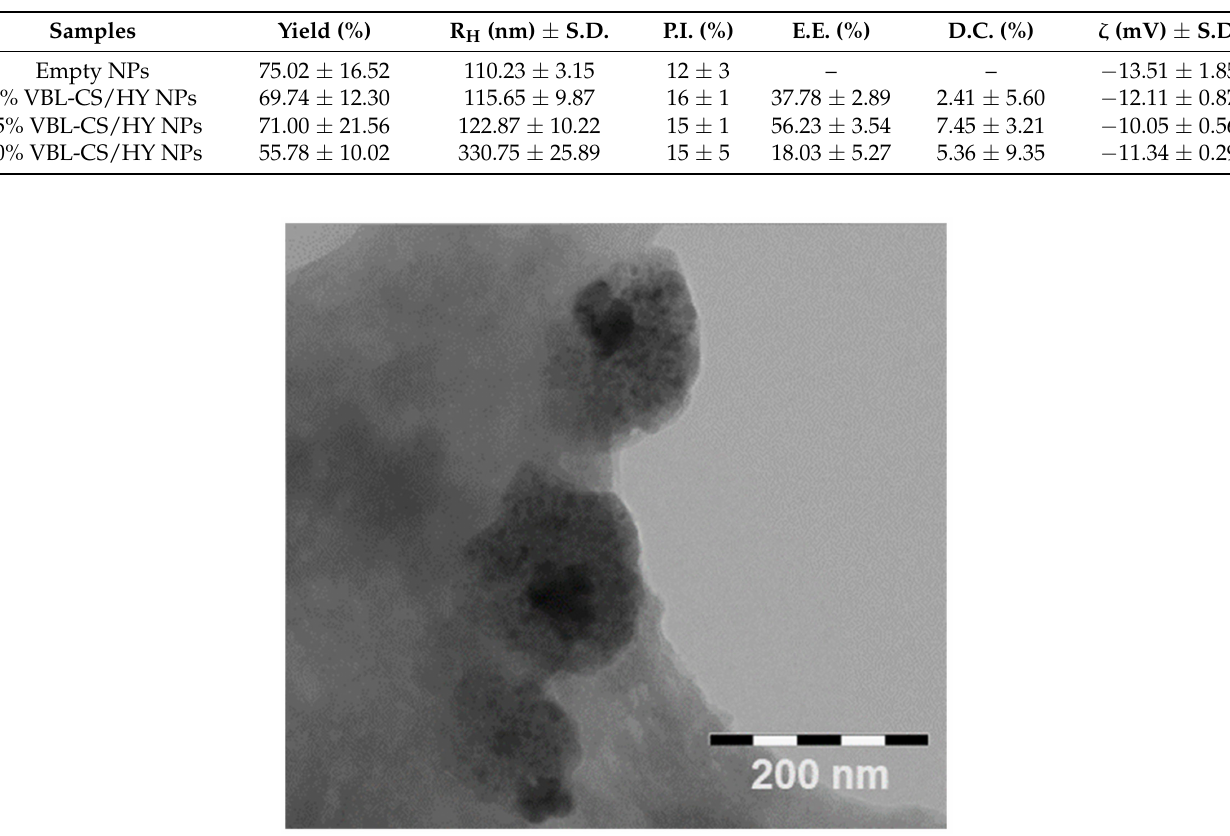
Table 3. Yield, hydrodynamic radius (R H ), polydispersity index (P.I.), encapsulation efficiency (E.E.),